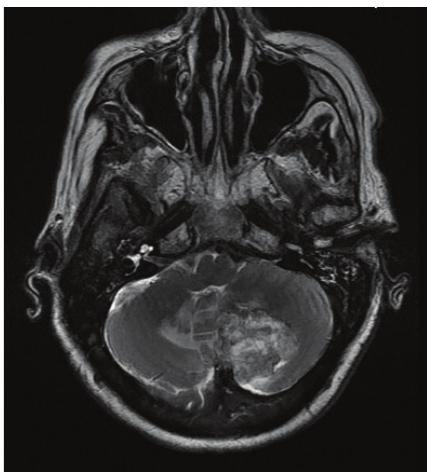
Figure 1: Magnetic resonance imaging of brain (axial view) showing a lobulated heterogeneous mass involving the medial left cerebellar hemisphere, measuring 4.0 × 3.5 × 2.5 cm associated with edema crossing the midline to the right cerebellar hemisphere, and com- pressing the fourth ventricle (the first case).